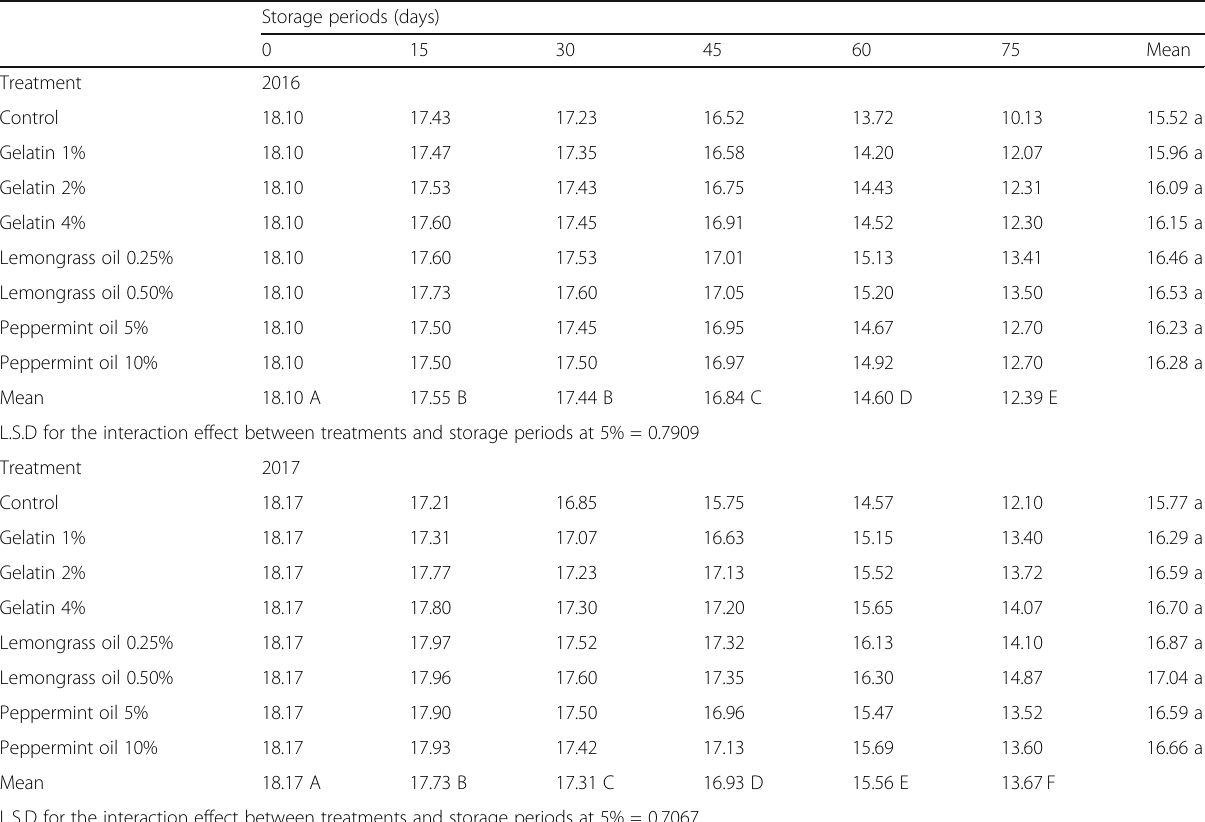
Table 3 Effect of gelatin, lemongrass oil, and peppermint oil on fruit firmness (Lb/inch 2 ) of Samany date palm fruits stored at 0.0 °C ± 2 during two experimental seasons Storage periods